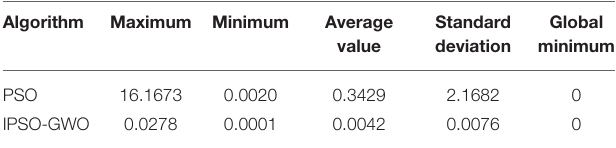
TABLE 5 | Booth function test results.